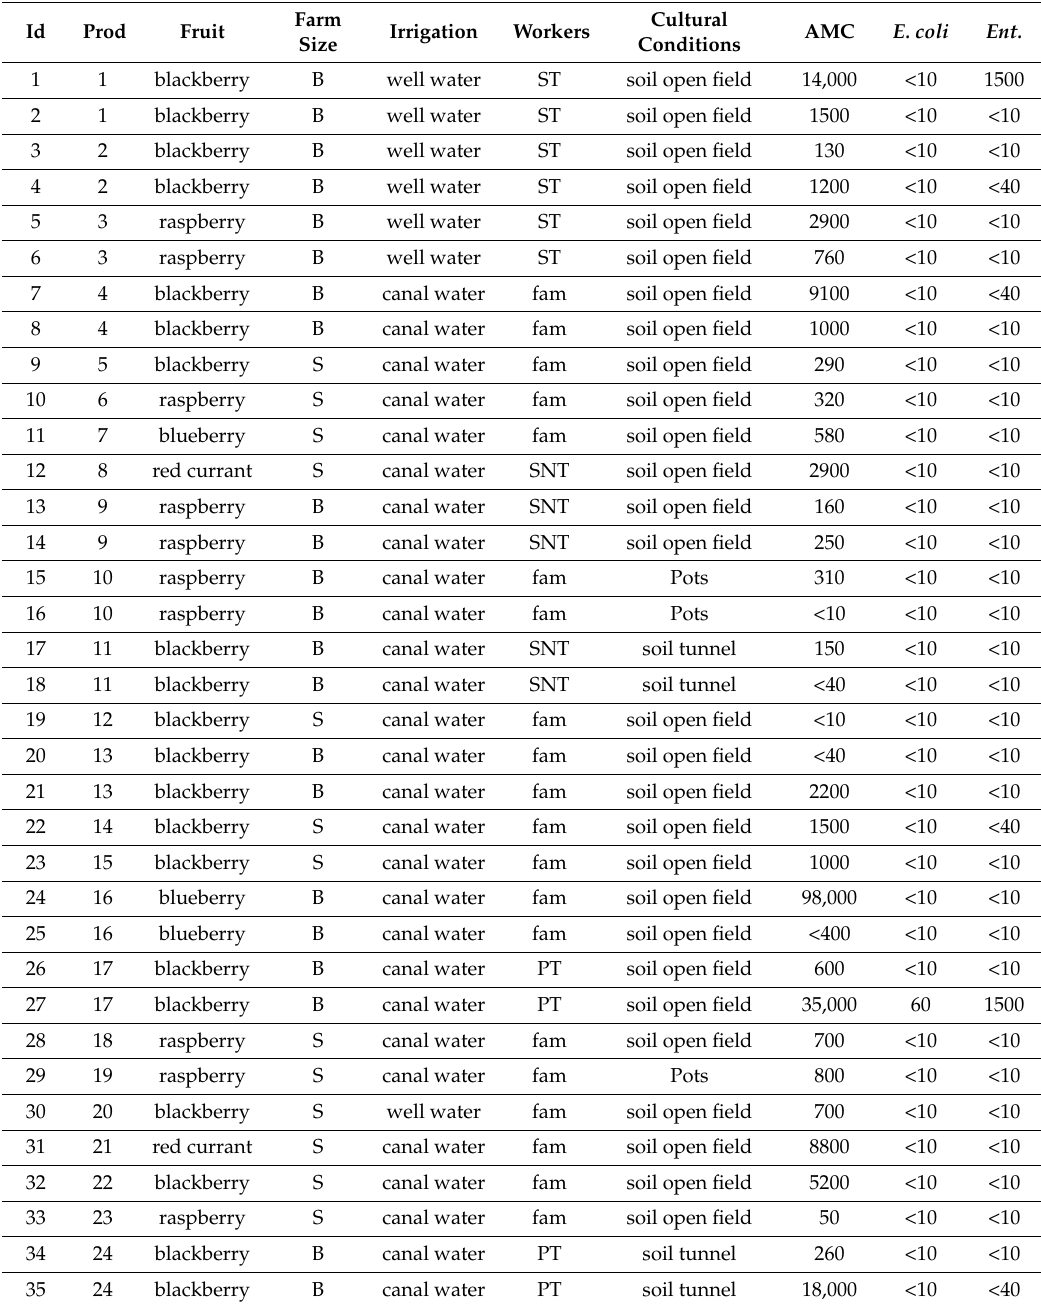
Characteristics of the farm involved in the sampling plan and results of the microbiology